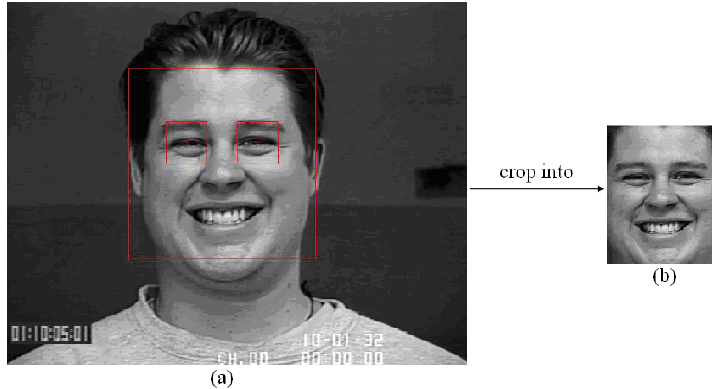
Figure 5. ( a ) Two eyes location of an original image from the Cohn-Kanade database. ( b ) The final cropped image of 110 × 150